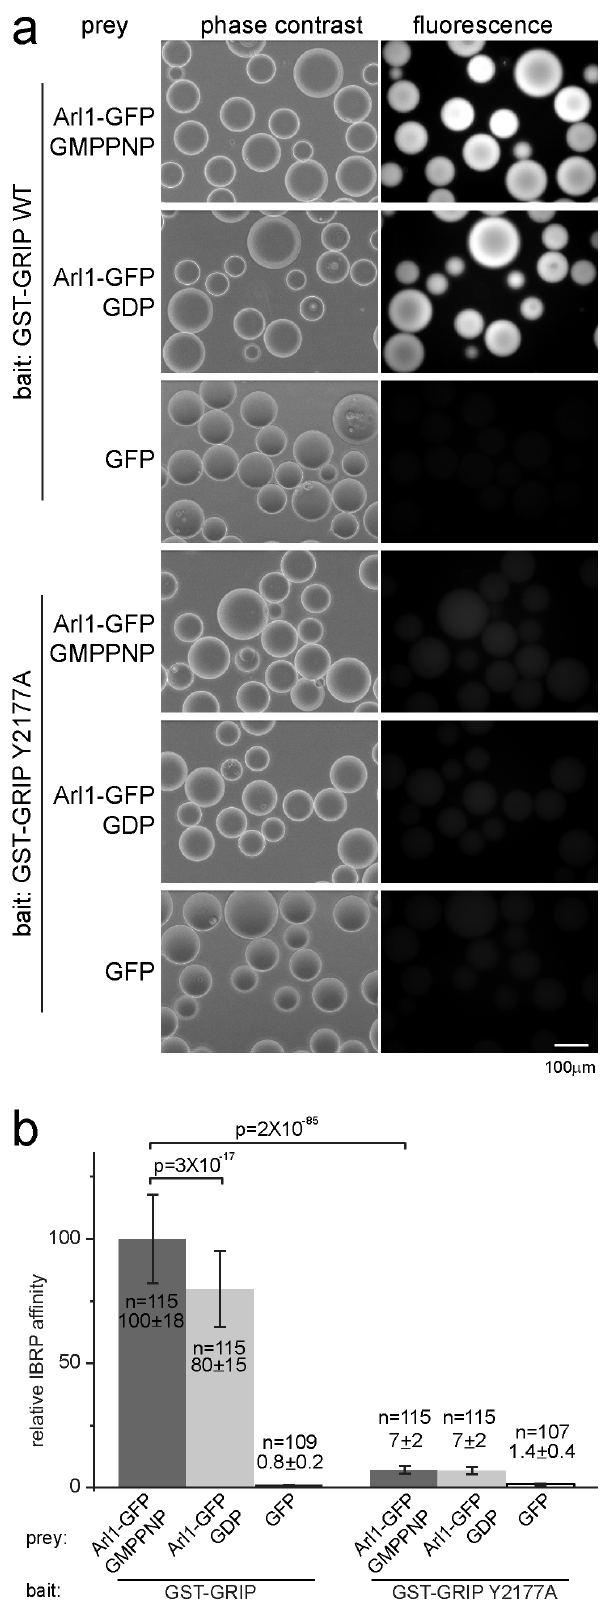
Figure 2. Studying the interaction of Arl1/GRIP by using GST- GRIP as bait and Arl1-GFP as prey in IBRP assay. (a) GST-GRIP